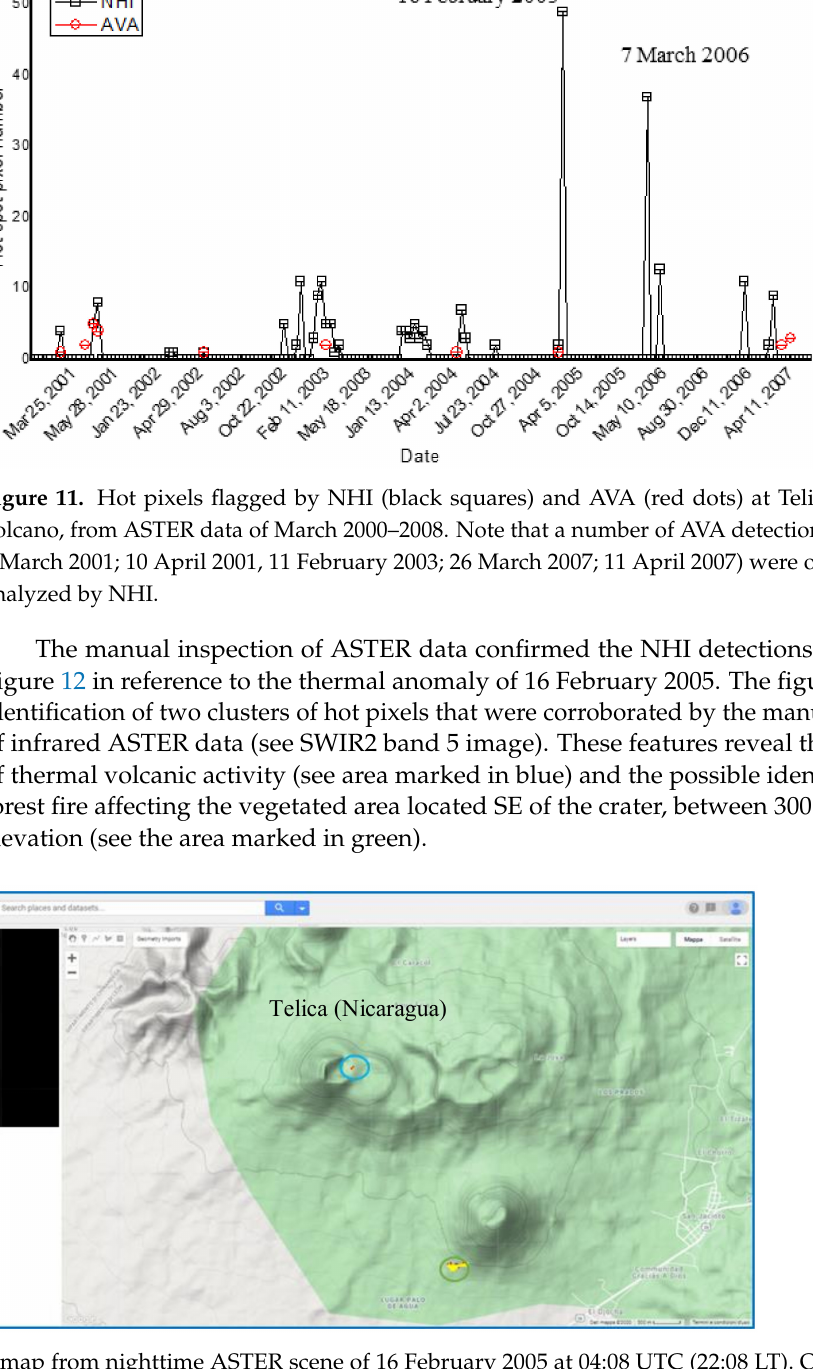
Figure 12. Thermal anomaly map from nighttime ASTER scene of 16 February 2005 at 04:08 UTC (22:08 LT). On top left side, the (SWIR2) band 5 image with bright pixels indicating hot